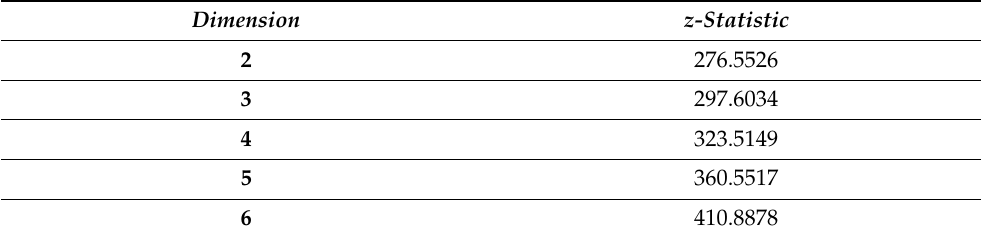
Table 3. BDS test